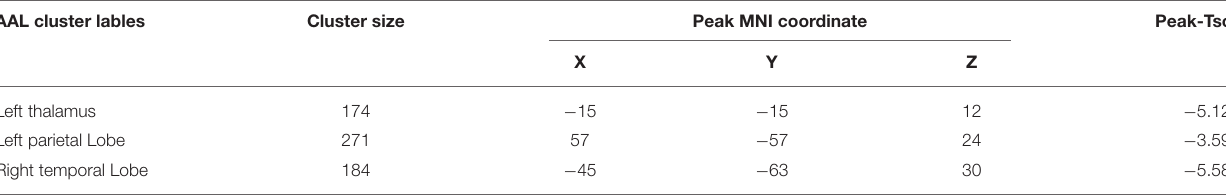
TABLE 2 | Regions showing significant differences in ReHo values between DYS and